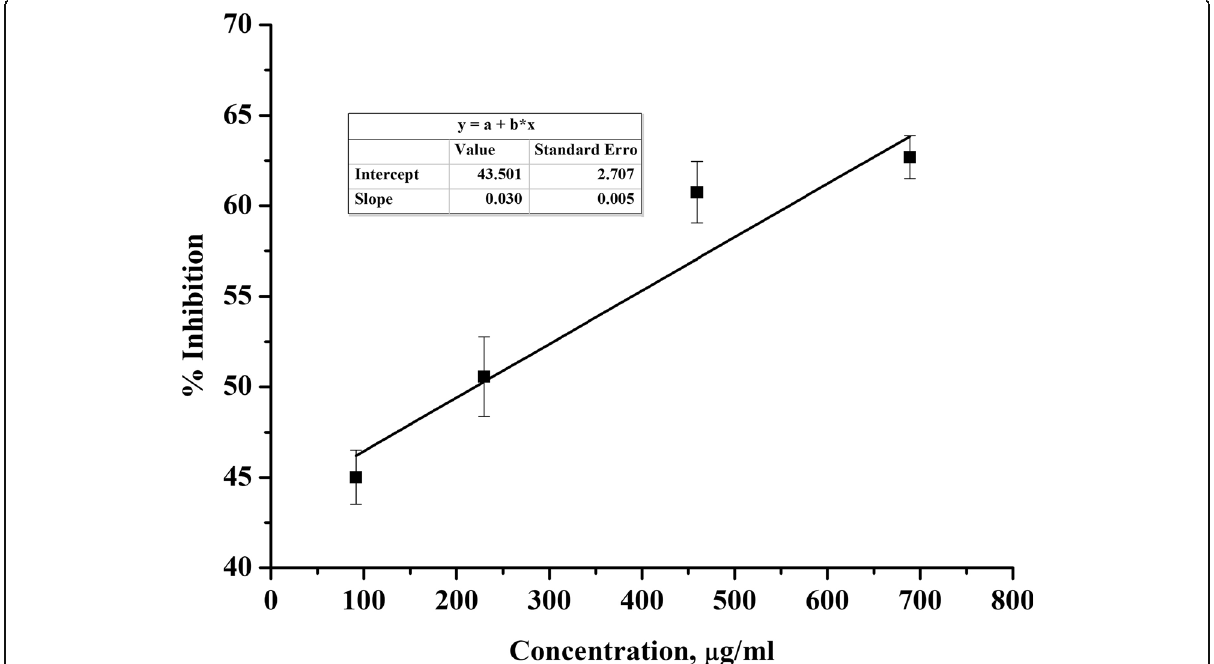
Fig. 4 % Inhibition of α -amylase by chloroform fraction of the bark extract of R . mucronata